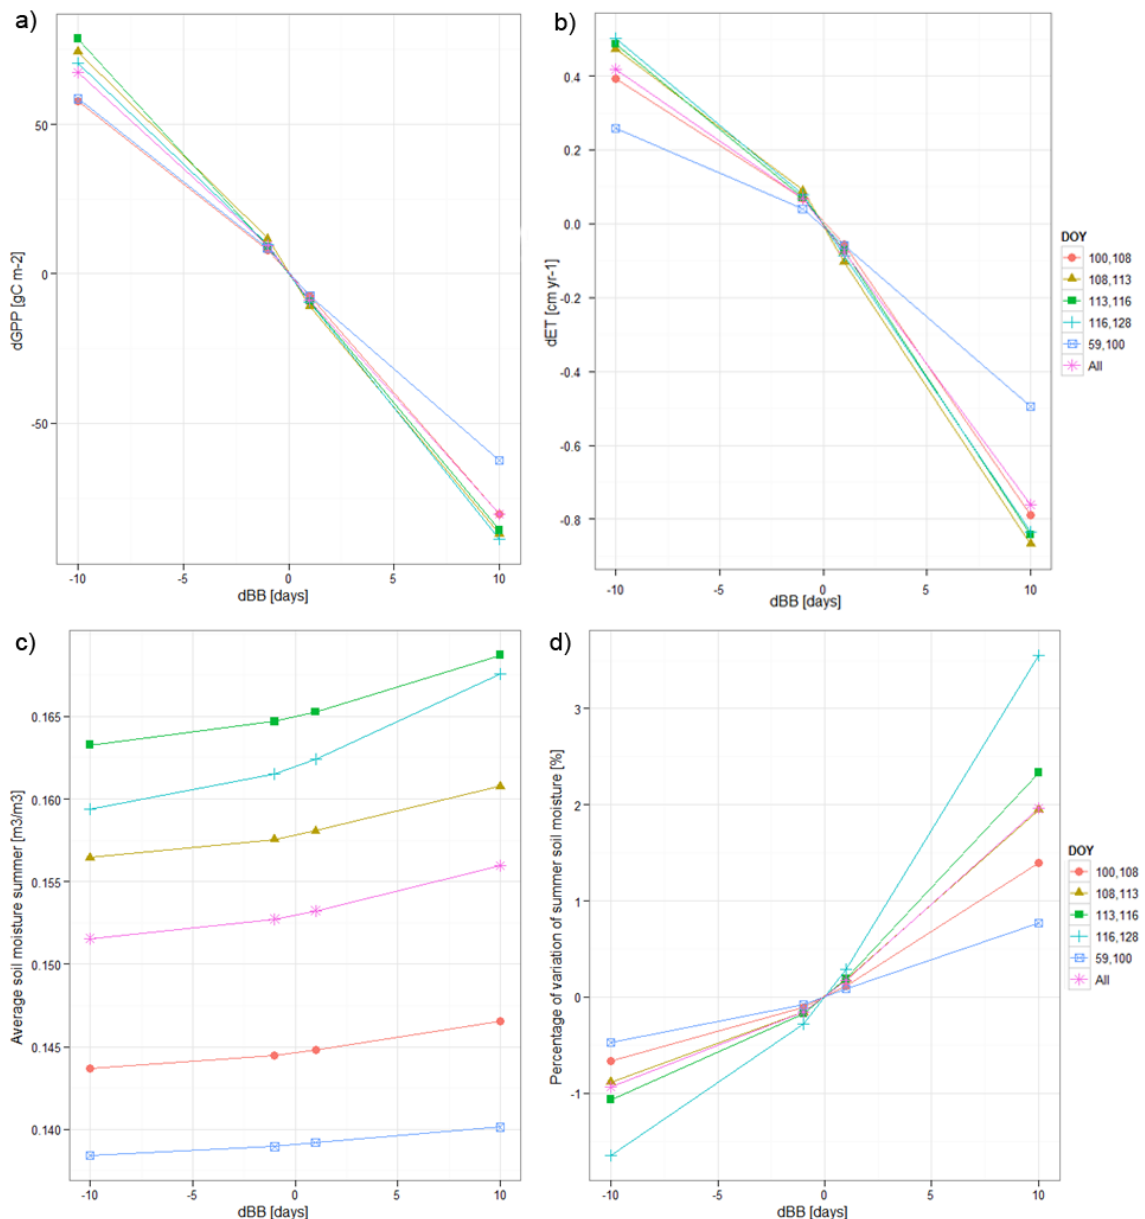
Fig. 11. (a) Within-years sensitivity of GPP ( 1 GPP) to variations of BB ( 1 BB); (b) within-years sensitivity of 1 ET to 1 BB; (c) within- years sensitivity of the average soil moisture in summer to 1 BB; (d) within-years sensitivity of the percentage of variations of summer soil moisture to 1 BB. Different lines represent the within-years sensitivity. Years are grouped according to the distribution of the day of the year (DOY) of bud-burst (i.e. from years with early bud-burst to years with late bud-burst as reported in the legend). The purple line with (*) represents the within-years sensitivity computed using all data.